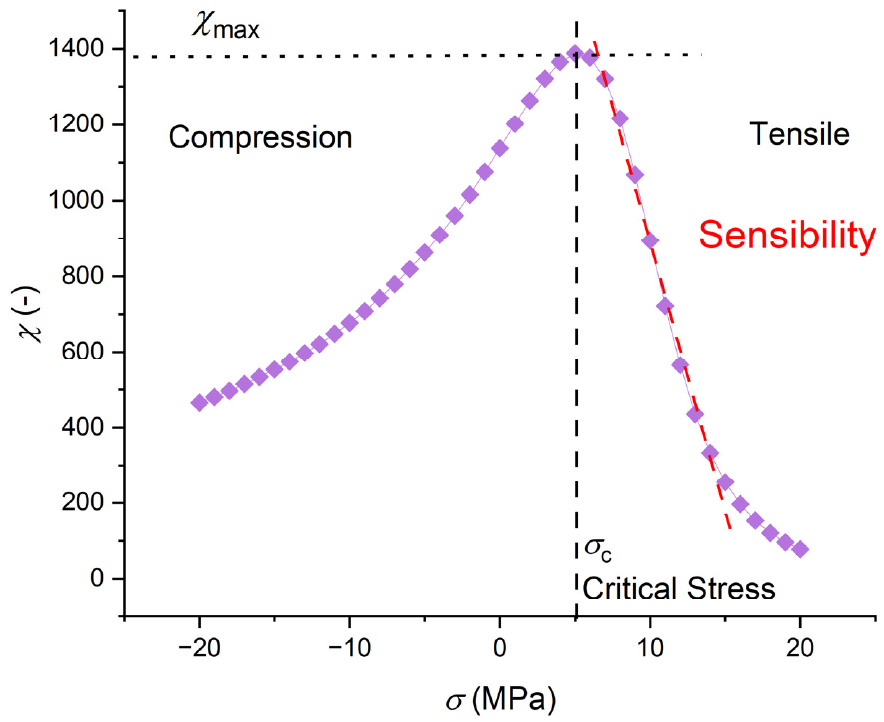
Figure 12. Stress sensor sensibility, calculated with M S = 1 MA/m, H a ~ 800 A/m, ( χ a = 1250) and with